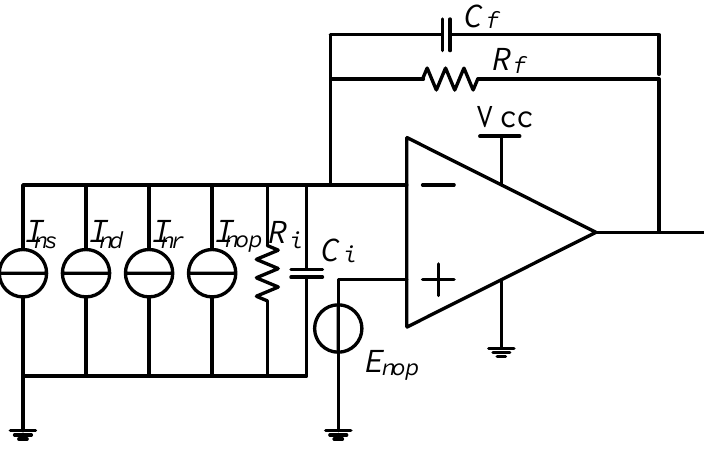
Figure 4. Equivalent noise model of photoelectric detection circuit.